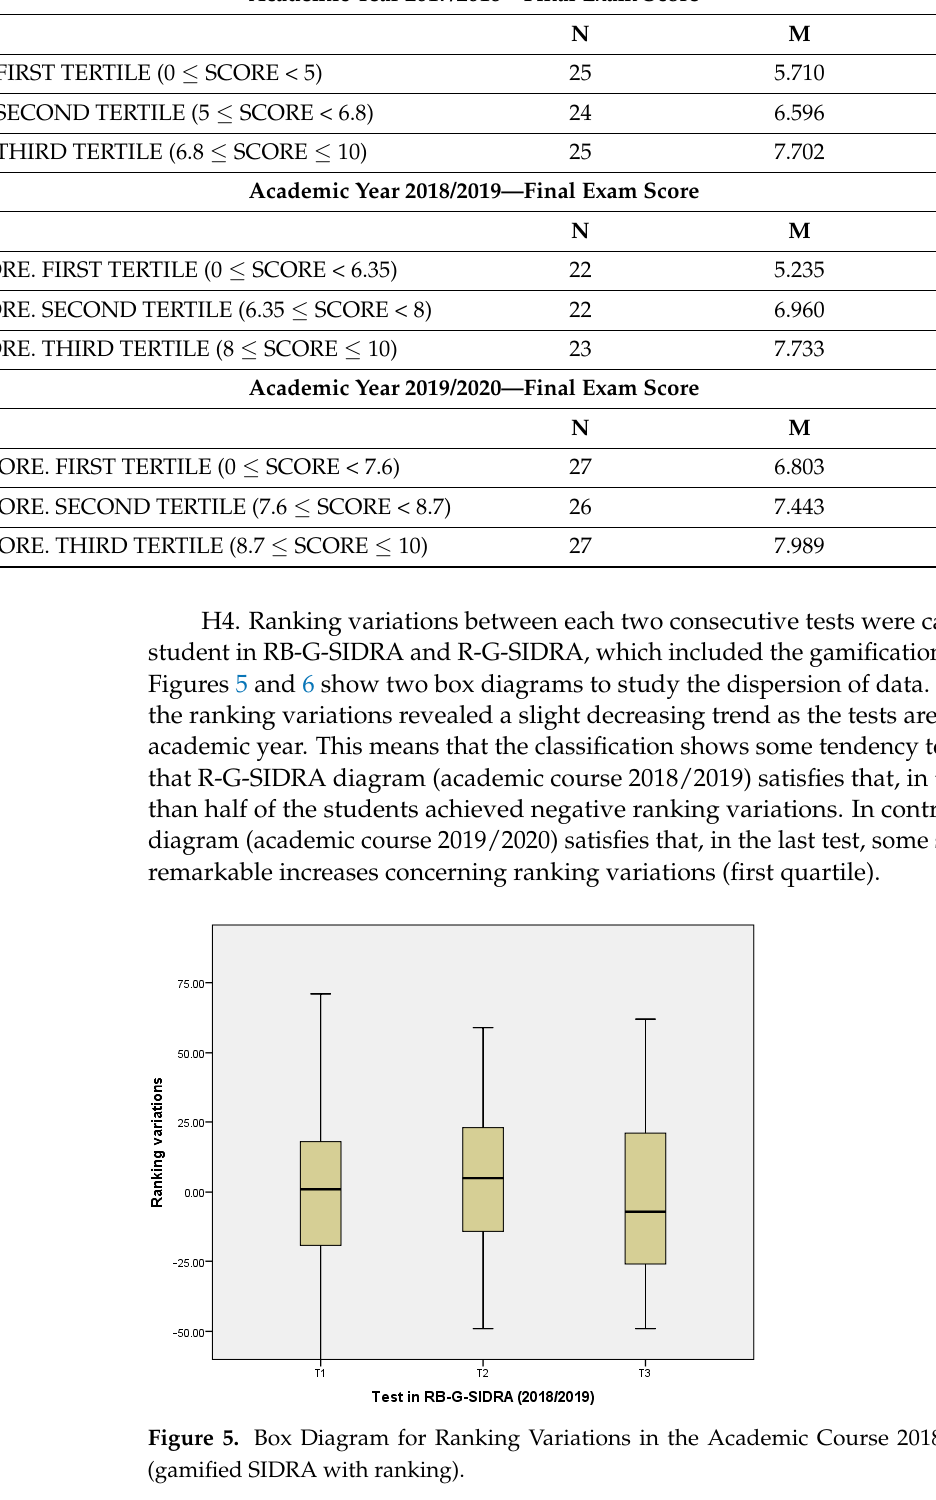
Figure 6. Box Diagram for Ranking Variations in the Academic Course 2019/2020 (RB-G-SIDRA). Table 4. Spearman’s Rank Correlation Coefficient Results between Individual and Team Score in RB-G-SIDRA (gamified SIDRA with ranking and badges) and R-G-SIDRA (gamified SIDRA with ranking). “Tx”: Test x; “CC”: Correlation Coef- ficient; “N”: Sample Size; “ p ”: p Value.